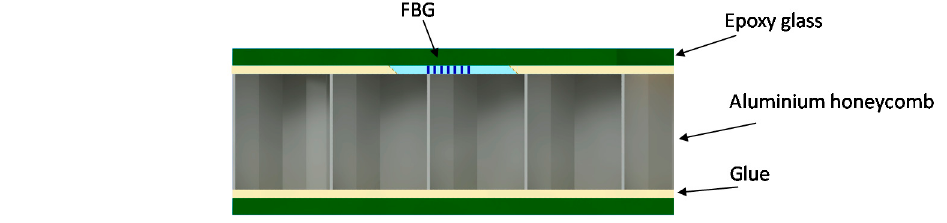
Figure 1. Schematic of transversal section of the multilayer